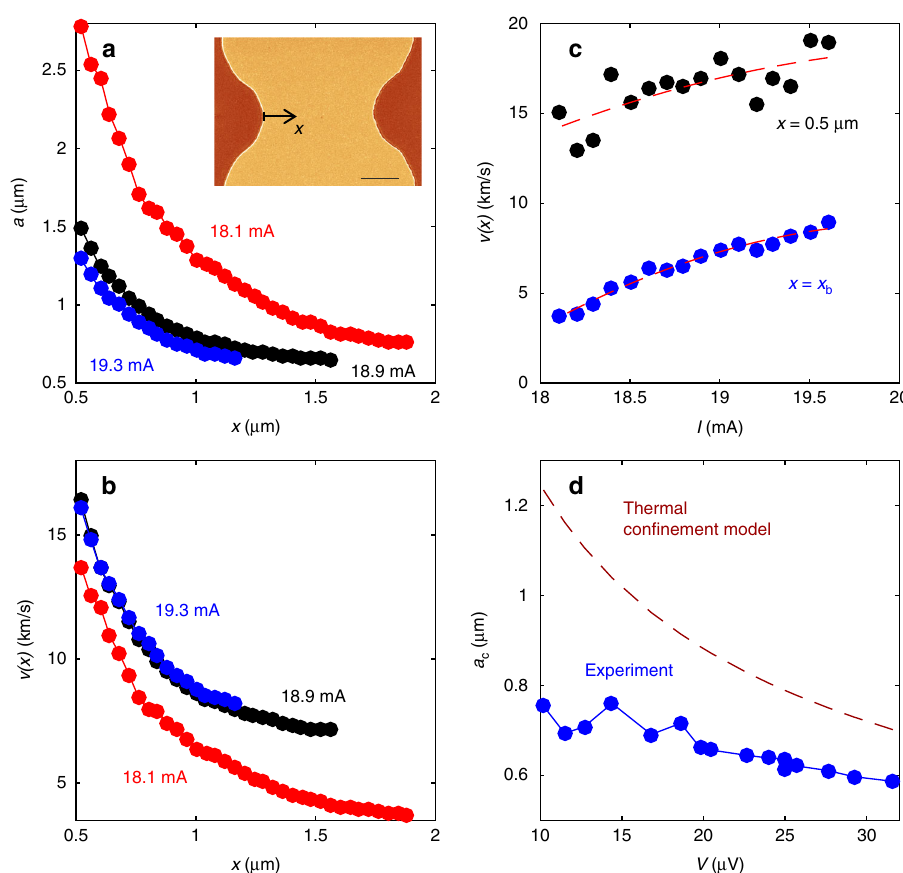
Fig. 4 Vortex velocities and spacing along the entrance stem channel. a Spacing between successive vortices a ( x ) along the stem from x = 0.5 µ m up to the bifurcation point x b at B a = 2.7 mT at various indicated currents. Inset: SEM image of the sample with marked x axis. The scale bar is 2 µ m. b Corresponding vortex velocities v ( x ) along the stem from x = 0.5 µ m up to the bifurcation point x b . c The vortex velocity vs. current at x = 0.5 µ m ( black ) and at x b ( blue ). The dashed lines are guides to the eye. d Vortex spacing a c at the bifurcation point x b vs. the voltage V across the microbridge ( blue ), compared to the theoretical estimate ( dashed ) based on the thermal con fi nement